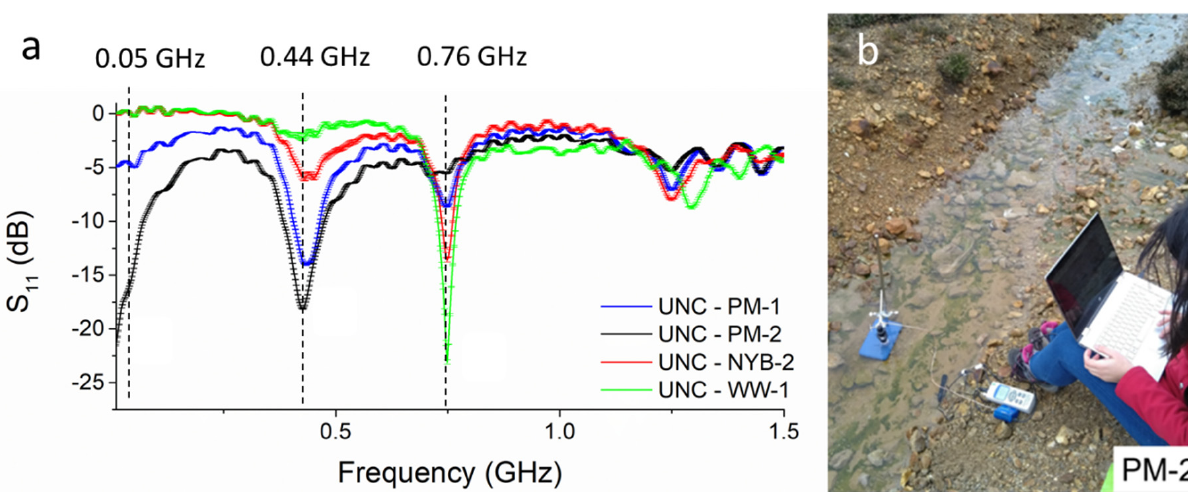
Figure 11. ( a ) Results for in situ measurements using a miniVNA tiny and eight-pair IDE sensors probing 4 water samples in three mining areas around the UK; ( b ) shows the most polluted water measured in this study (PM-2) and the measurement configuration.